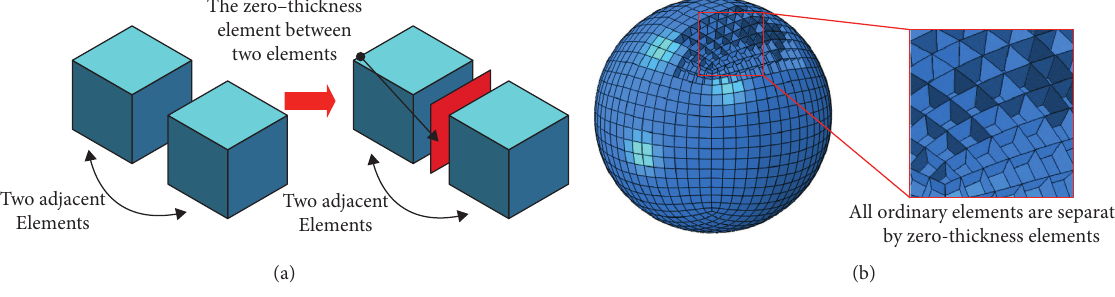
Figure 10: Zero-thickness vulnerable elements.